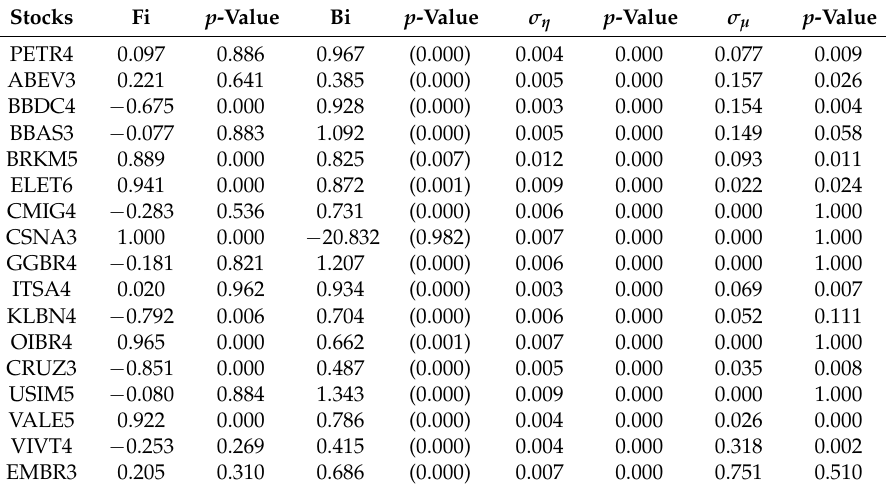
Table A1. Coefficients of the model with no exogenous variables.